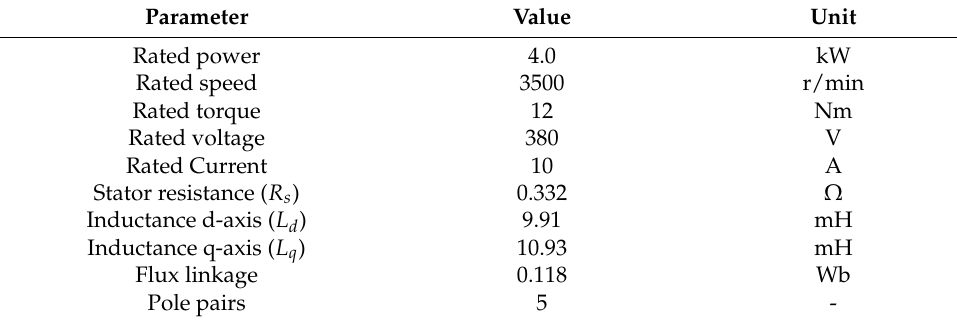
Table 1. IPMSM Parameters.